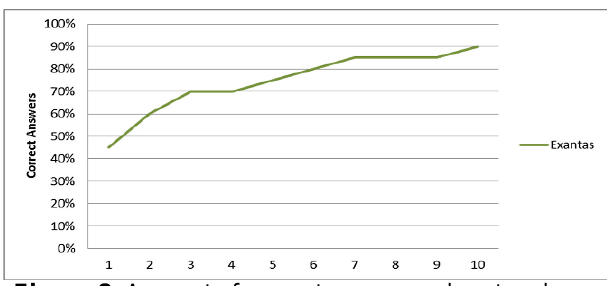
Figure 8. Amount of correct answers when teacher consults Exantas app